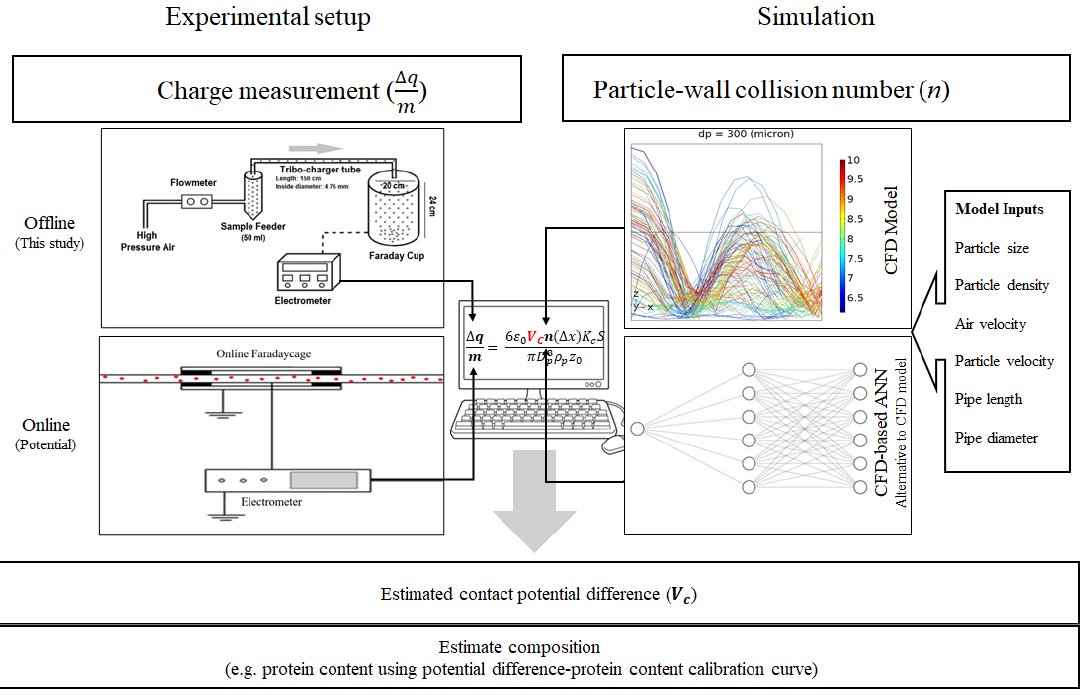
Figure 1. Schematic illustration of experimental ( Left ), and computational section ( Right ) of powders characterization method based on experimental charge measurement and computational estimation of particle-wall collision numbers.